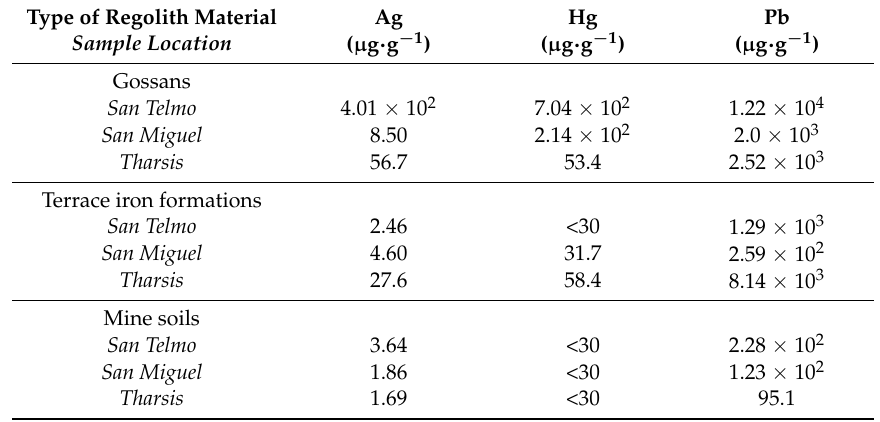
Table 2. The Ag, Hg and Pb concentrations within gossan, terrace iron formations and mine soils based on ICP-AES